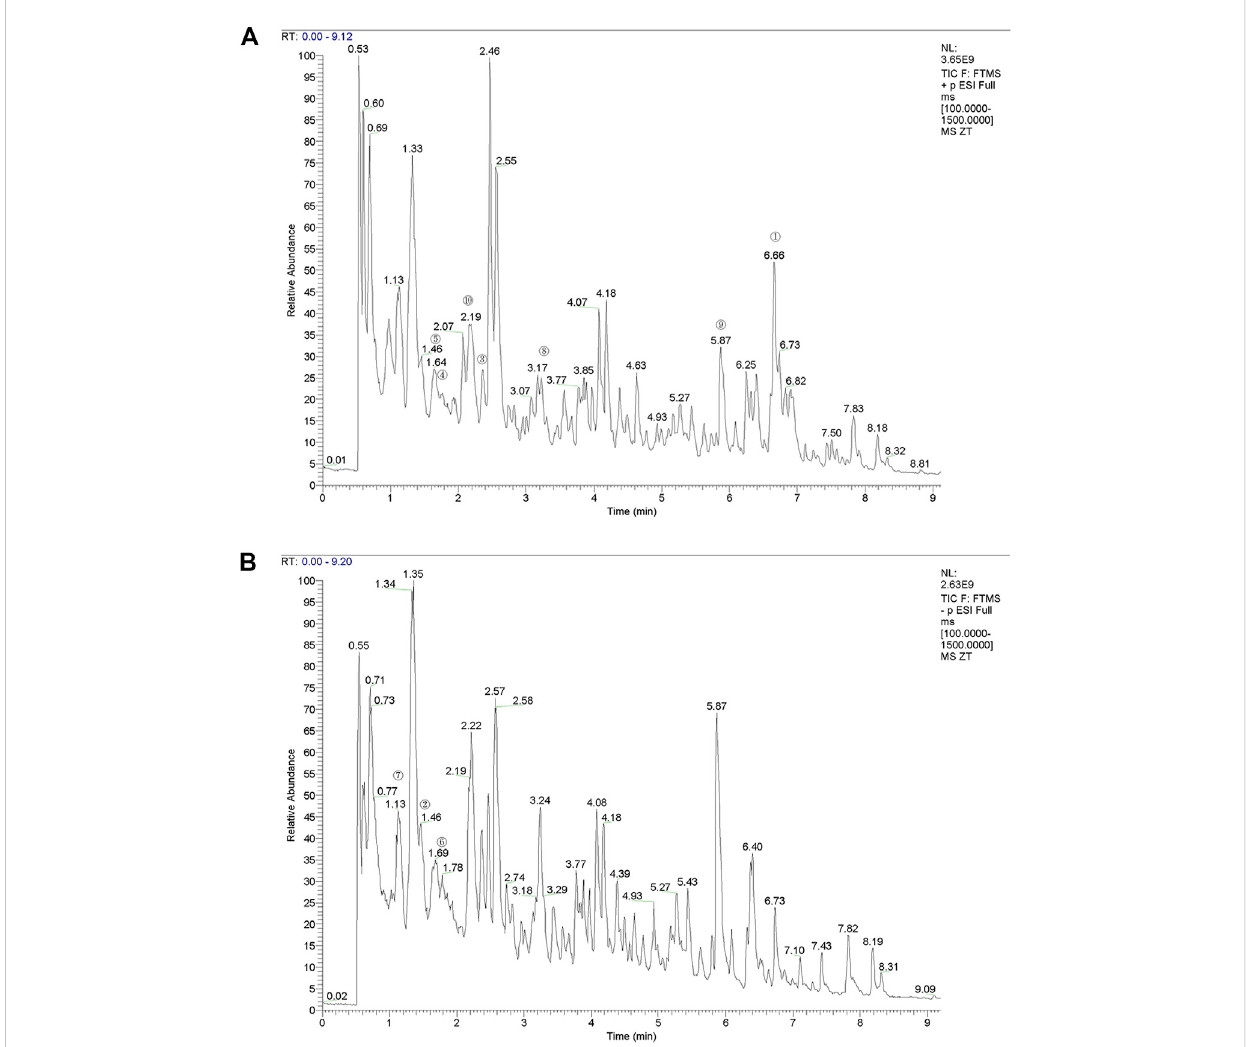
FIGURE 2 The totalion chromatograms (TIC) ofYQYXF that wereobtained inpositive ion modeand negativeion mode. (A) UHPLC-QE-MSanalysisbase peak intensity chromatogramsofYQYXFinpositiveionmode. (B) UHPLC-QE-MSanalysis basepeakintensity chromatogramsofYQYXFinnegativeionmode.